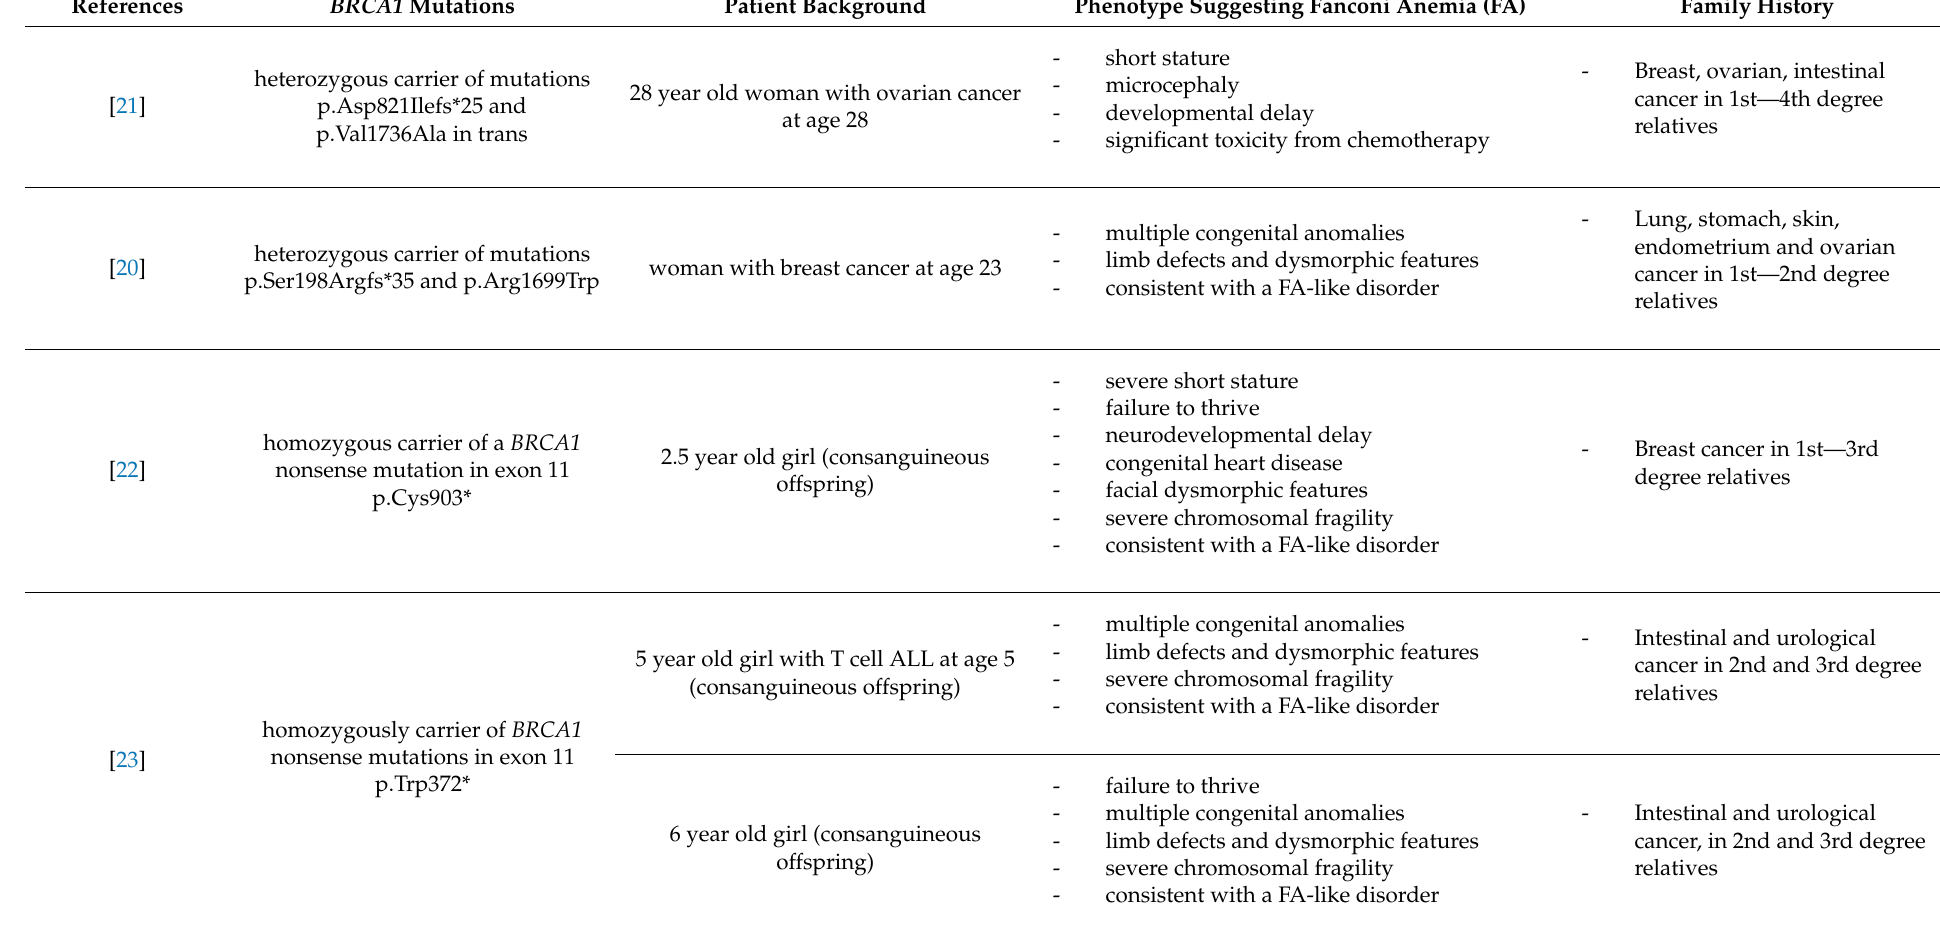
Table 1. List of probands reported with biallelic BRCA1